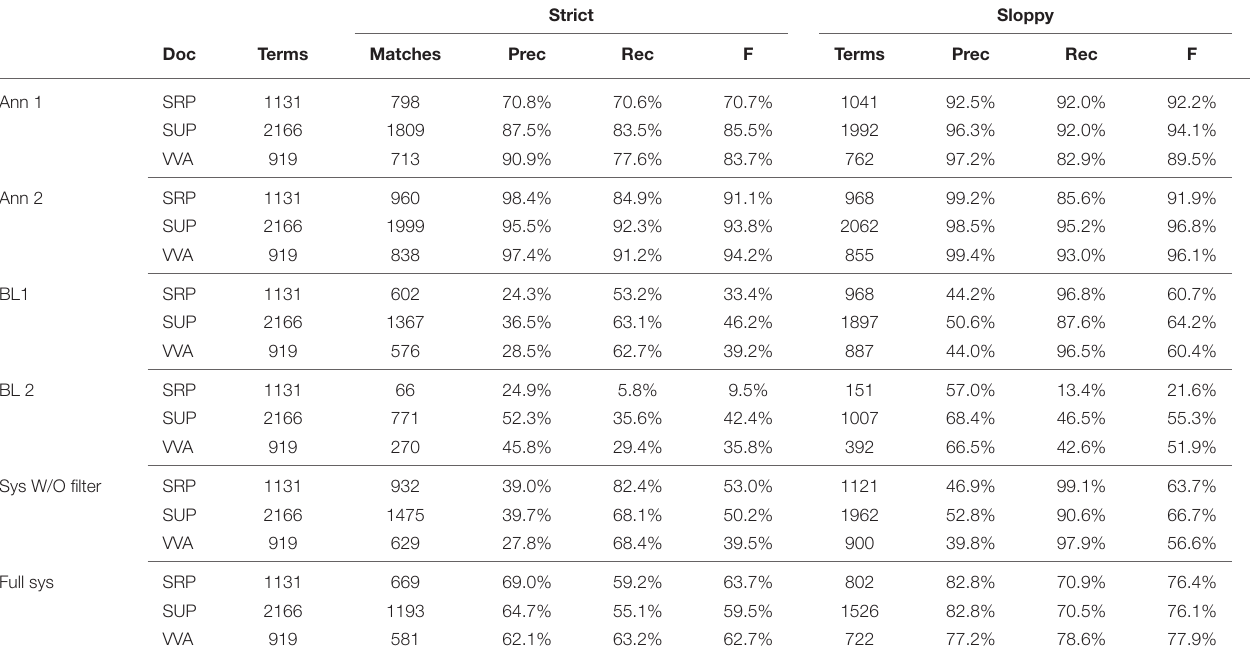
TABLE 2 | Evaluation of terminology chunking annotation and system output.